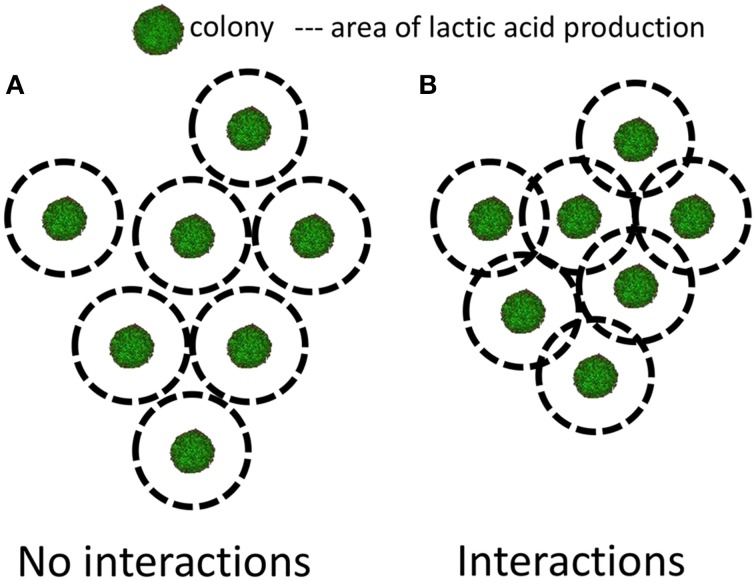
Representation of two situations of neighboring colonies. (A) When the production of lactic acid of one colony does not impact on its neighbors and (B) when the production of lactic acid of one colony does impact on its neighbors. Adapted from Malakar et al. (2002a) and Wimpenny (1992).